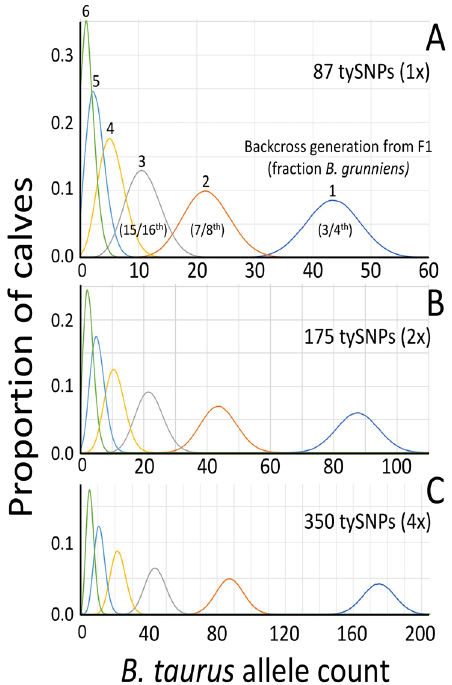
Figure 8. Simulated detection of cattle introgression with tySNPs. ( A ), ( B ) and ( C ) Simulated results with 87, 174, and 350 tySNPs, respectively. Each peak represents one backcross generation removed from the F1 hybridization event. (Figure8_